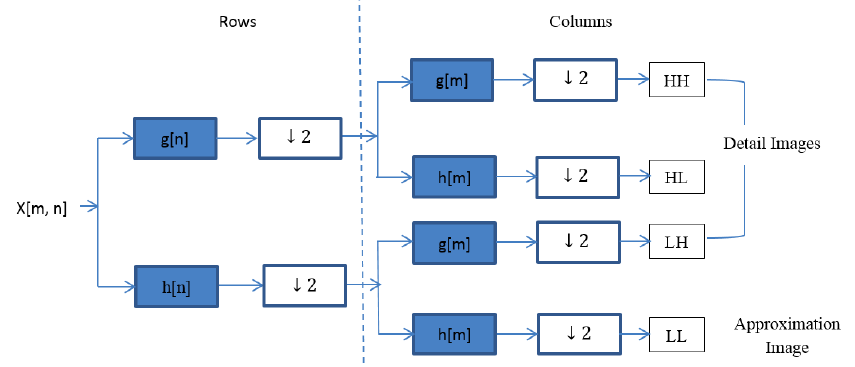
Figure 2. Schematic diagram of one-level two-dimensional DWT image decomposition